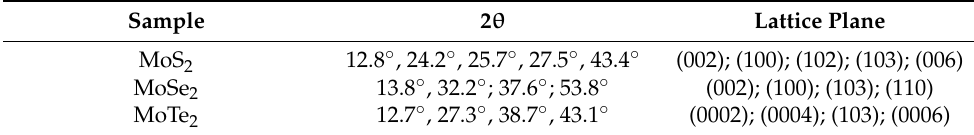
Figure 1. XRD spectra for the synthesized MoX 2 nanomaterials. Table 1. XRD parameters of the MoX 2 nanoparticles.